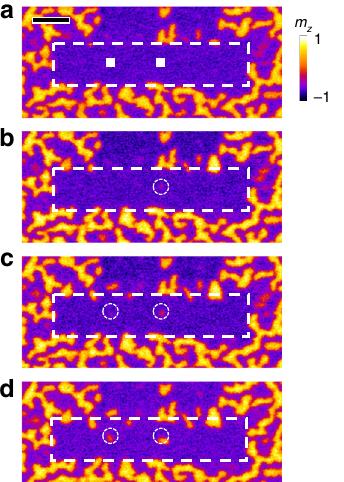
Fig. 3 X-ray-induced single skyrmion creation. a Magnetic domain pattern (obtained by STXM) after introducing a uniform exchange bias in the middle channel (dashed area, 1 × 7 μ m 2 ). The two squares indicate the areas of 200 × 200 nm 2 scanned by using X-rays for creating two individual skyrmions at zero fi eld. b – d The right skyrmion is fi rst created and then the left one is created. During the reading process, i.e., a low- fl ux X-ray illumination, the previously created skyrmion (the right one) increases its size ( c ). The size of these two skyrmions can be further increased by performing another reading process ( d ). The white circles have a diameter of 400 nm. The scale bar in a is 1 μ m. The color represents the out-of-plane component of the magnetization ( m z